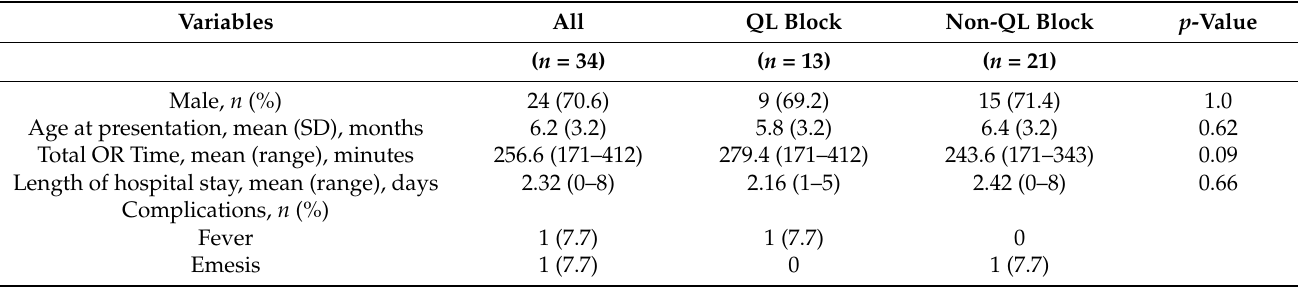
Table 1. Demographic and clinical characteristics of patients ( n = 34).